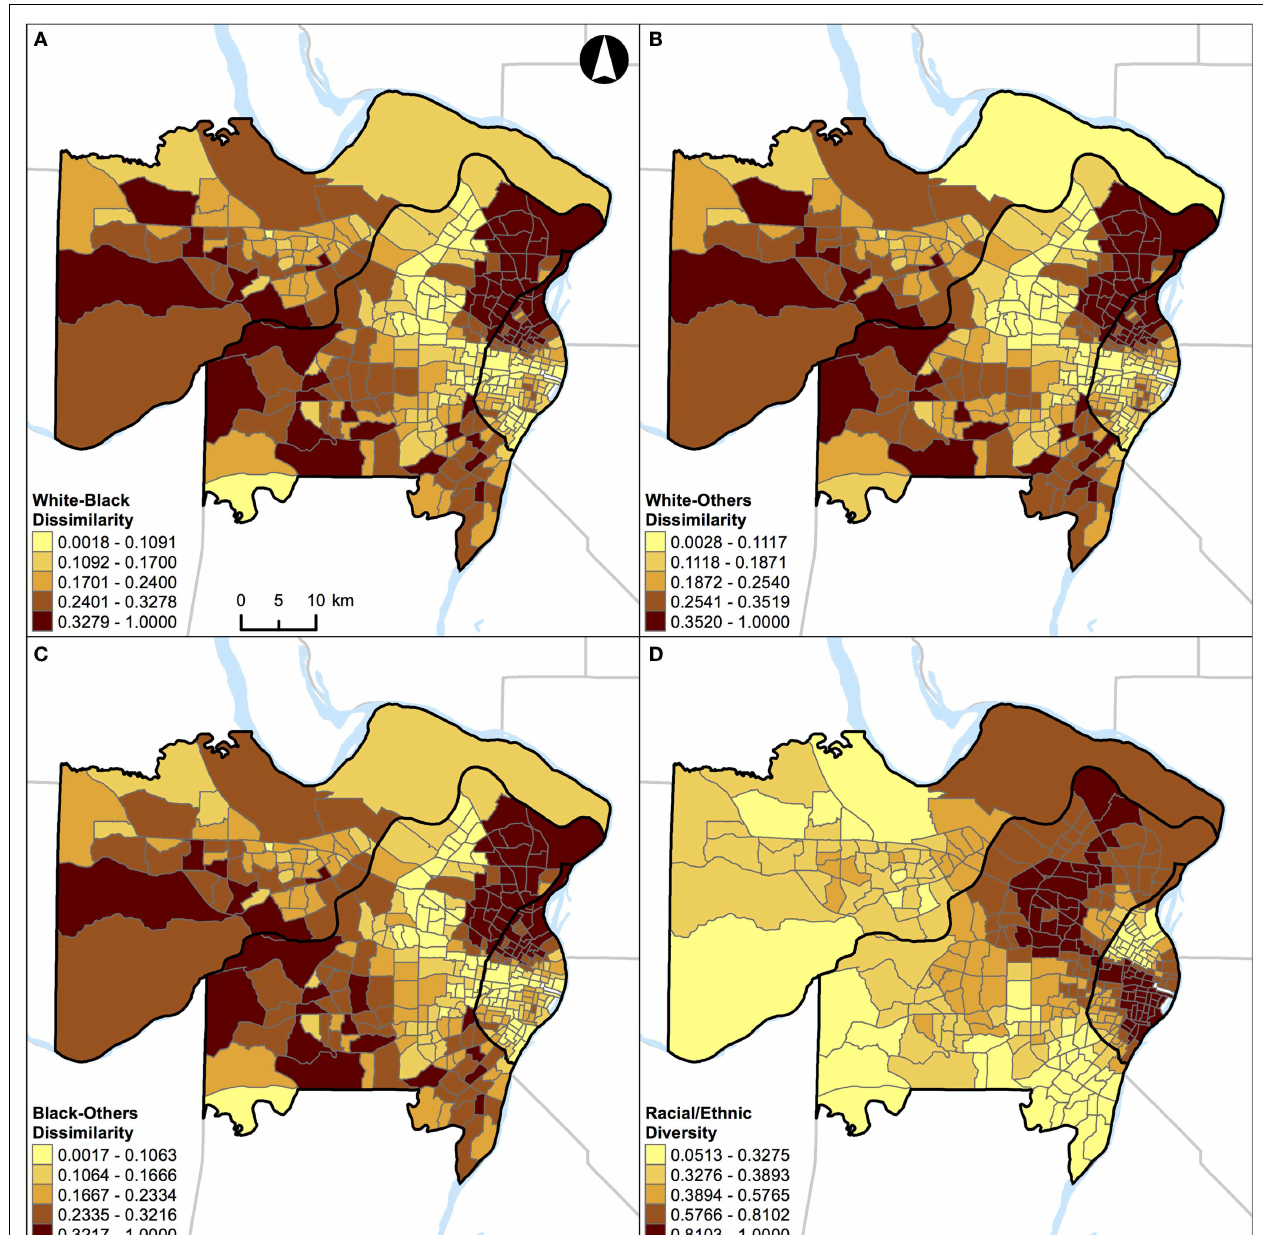
FIGURE 4 | Geographic distribution of local spatial evenness measures in St. Louis, MO, USA (340 census tracts) . (A) White–black dissimilarity, (B) white–others dissimilarity, (C) black–others dissimilarity, and (D) racial/ethnic diversity. A quantile classification scheme was used to display the levels of local